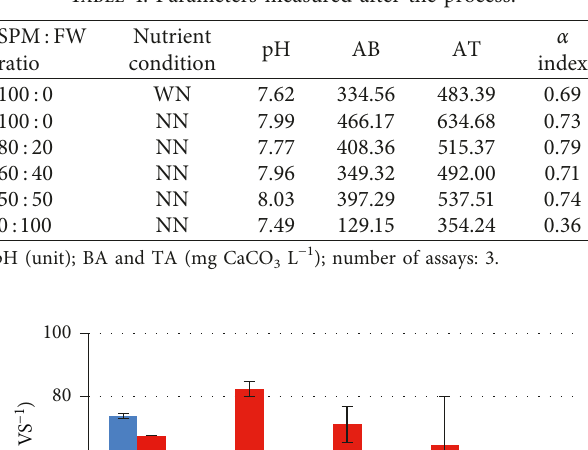
Table 4: Parameters measured after the process.